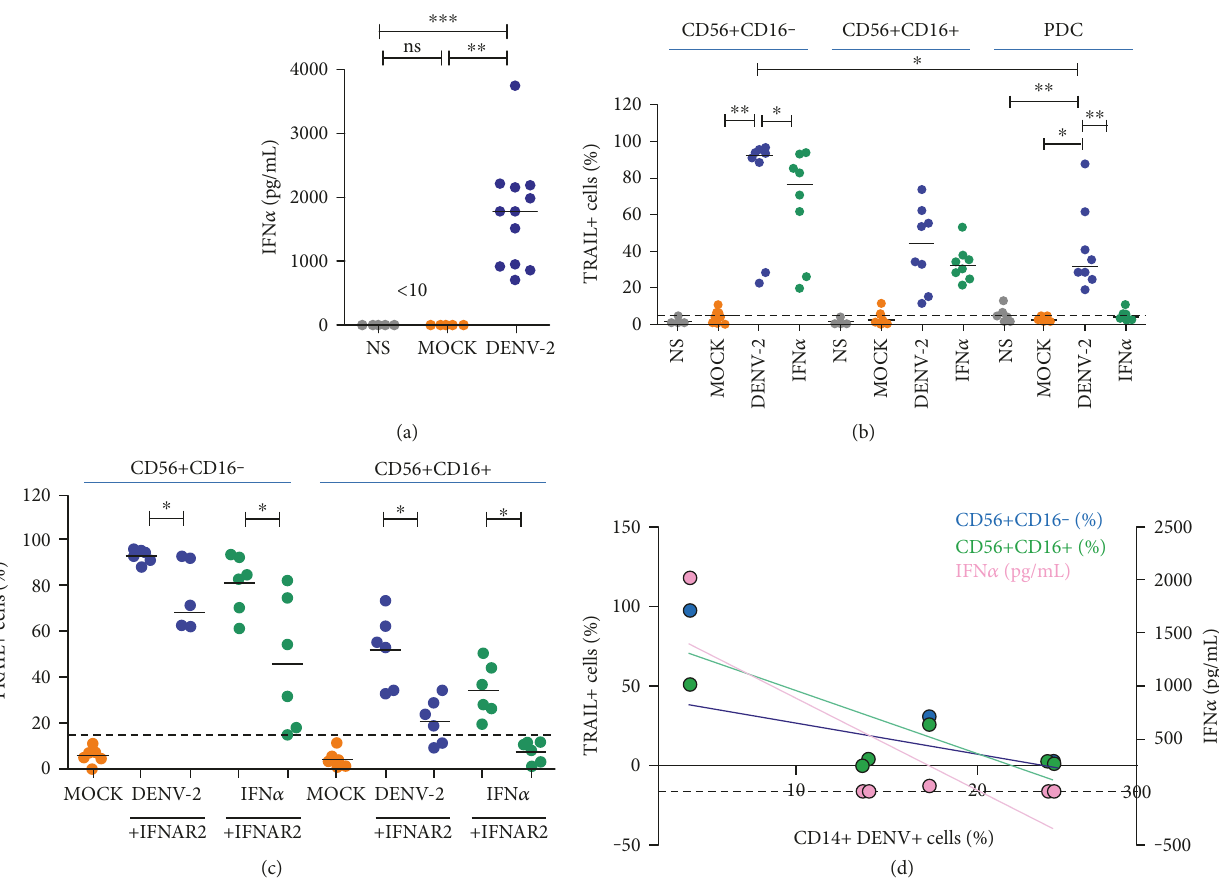
Figure 4: Type I interferon involvement in TRAIL expression on NK cells. Healthy donors ’ PBMCs were freshly obtained and subsequently stimulated with DENV-2 at MOI 10, recombinant IFN α (150ng/mL) or negative controls as MOCK (uninfected C636 cell culture supernatant), or not stimulated (NS) for 18 hours. Type I interferon subunit receptor 2 (IFNAR2) was blocked by treating cells with 1.5 μ g/mL of IFNAR2-neutralizing antibody 30min prior to viral stimulation. IFN α was detected in the cell culture supernatant by ELISA. (a) IFN α production by PBMC cultured with DENV-2 (blue) or MOCK (orange) in comparison with basal levels